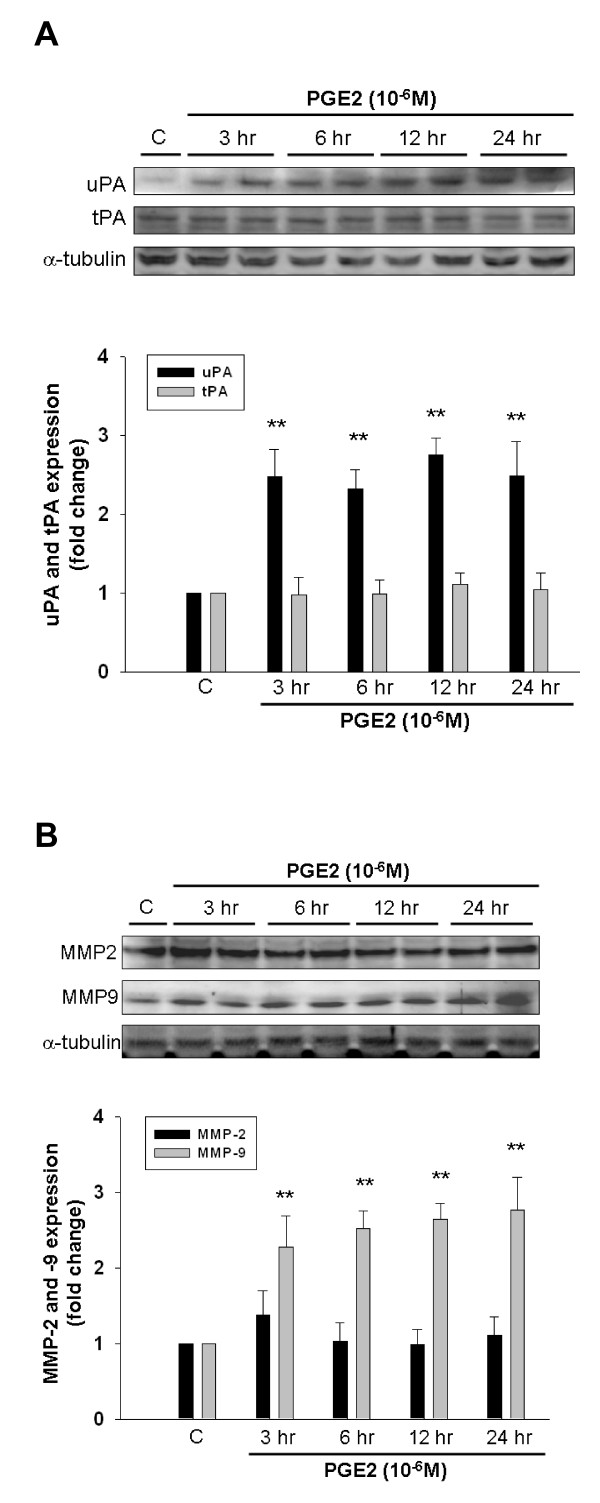
PGE2 induces expression of uPA and MMP-9 in human LoVo colon cancer cells. LoVo cells cultured in DMEM were treated with PGE2 (10-6M) for 3 h, 6 h, 12 h and 24 h, and subsequently observed protein level of uPA, tPA (A), MMP-2 and MMP-9 (B) in LoVo cells by immunoblotting assay. The responses to different time periods of PGE2 treatment were measured by the immunoblotting assay. **, p < 0.01 versus control (mean ± SE, n = 3).